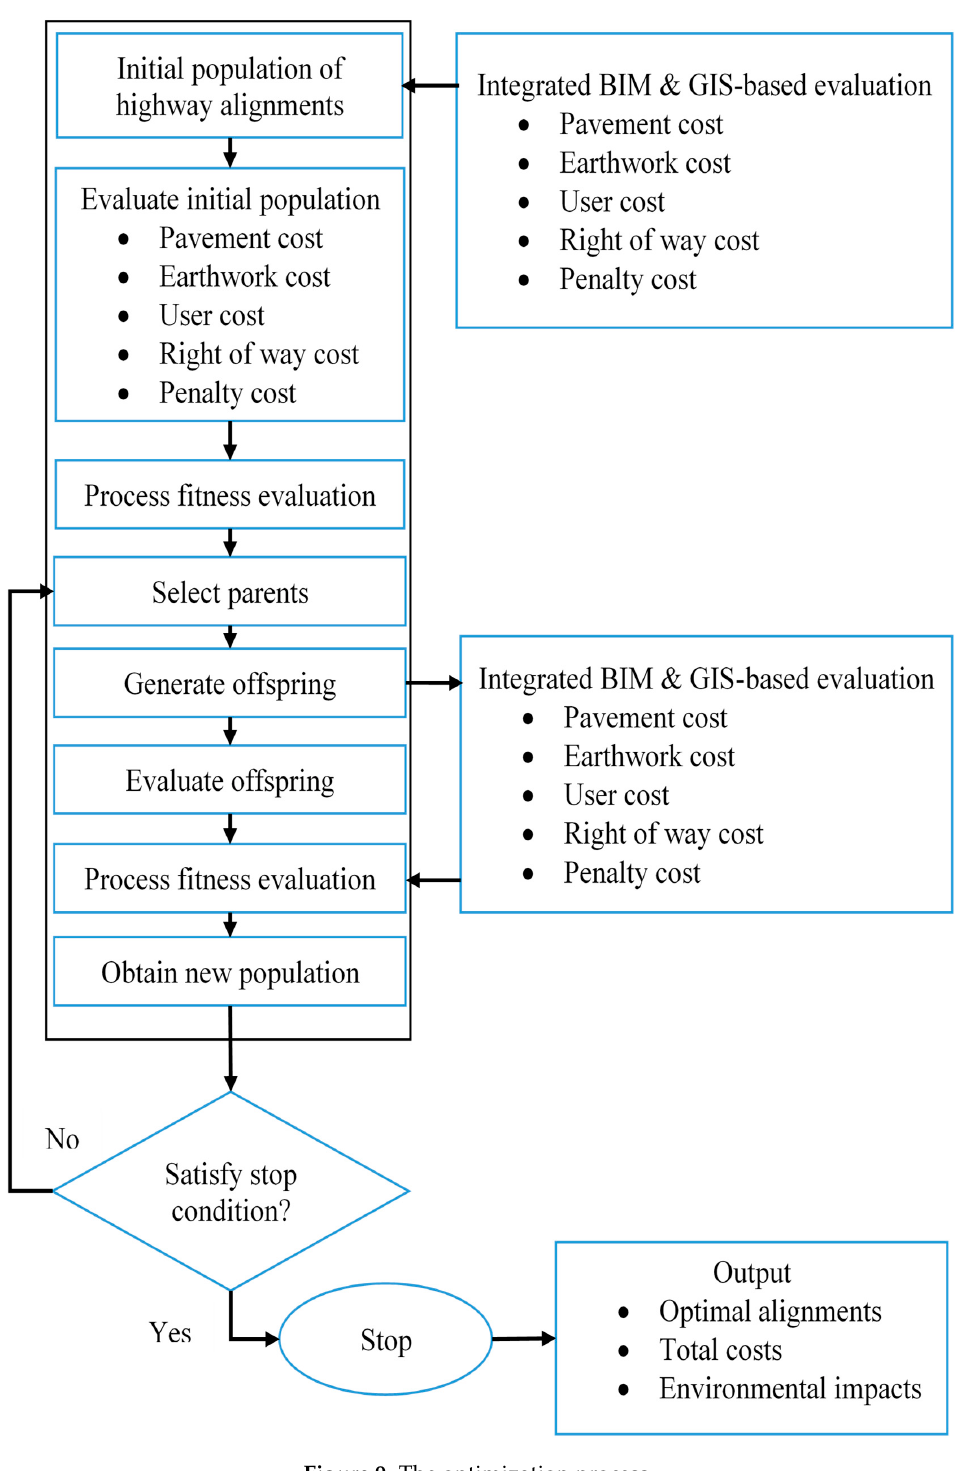
Figure 9. The optimization process.